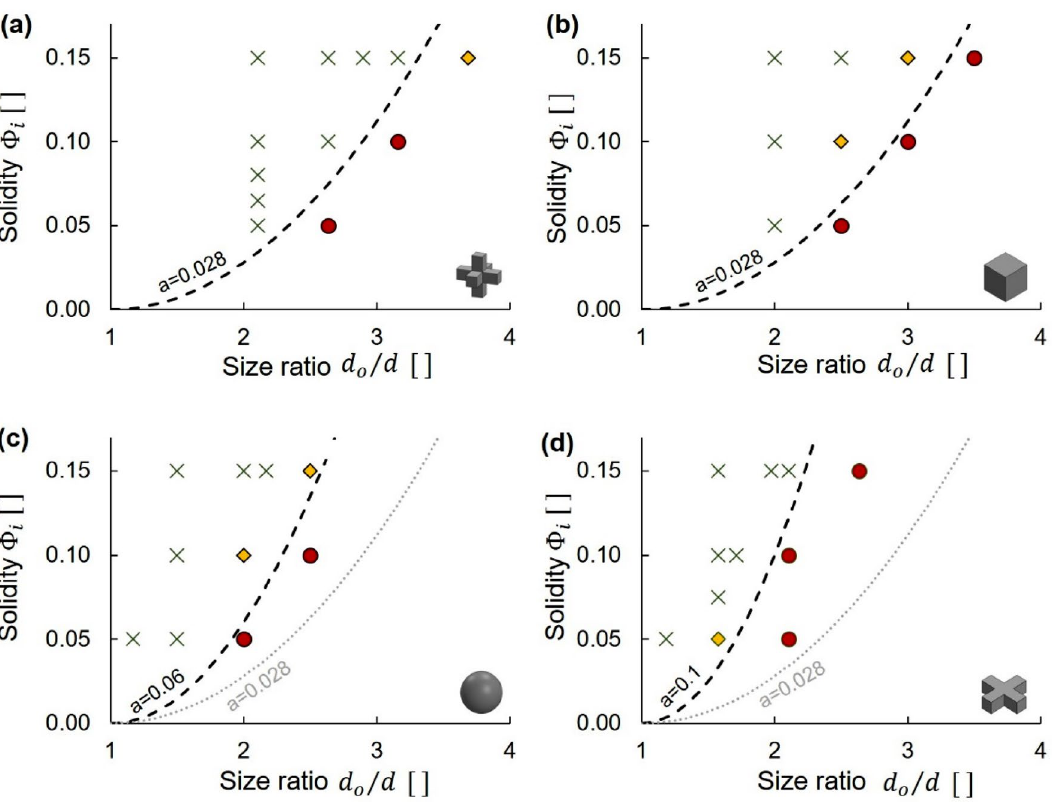
Figure 6. Particle-laden fluid flow: Clogging domains before a discharge suspension volume V s < 800 ml (experimental results). Space defined by the initial suspension solidity Φ i and the orifice-to-particle size ratio d o / d . Green: clogging probability p = 1. Red: p = 0. Yellow: 0 < p < 1. Lines: domain boundaries follow a second- 2 order power equation φ = a [ ( d o / d ) − 1 ] . The light gray lines added for mutual reference. Figure represents 280 independent experimental